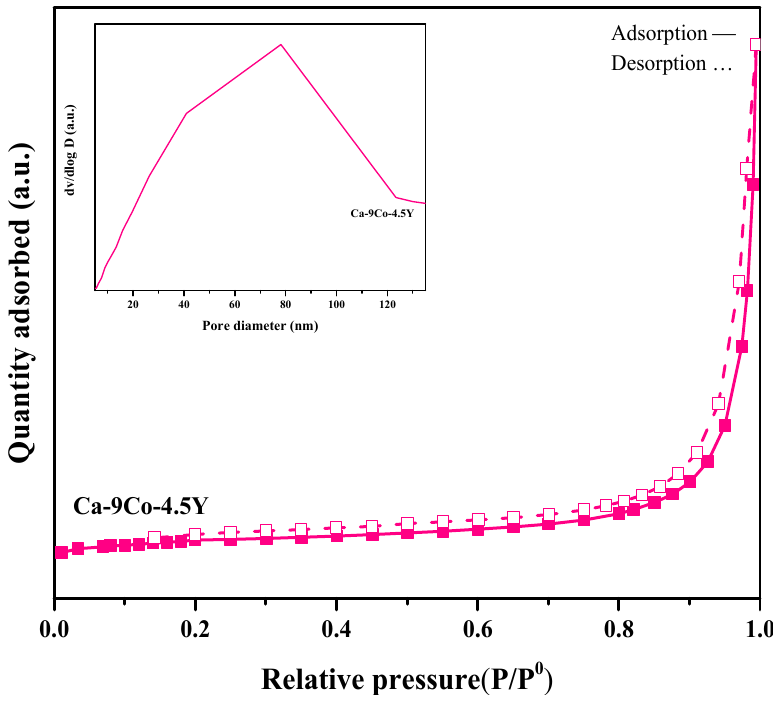
Figure 11. N 2 adsorption–desorption isotherm and pore size distribution of used optimal sample (Ca ‐ 9Co ‐ 4.5Y).